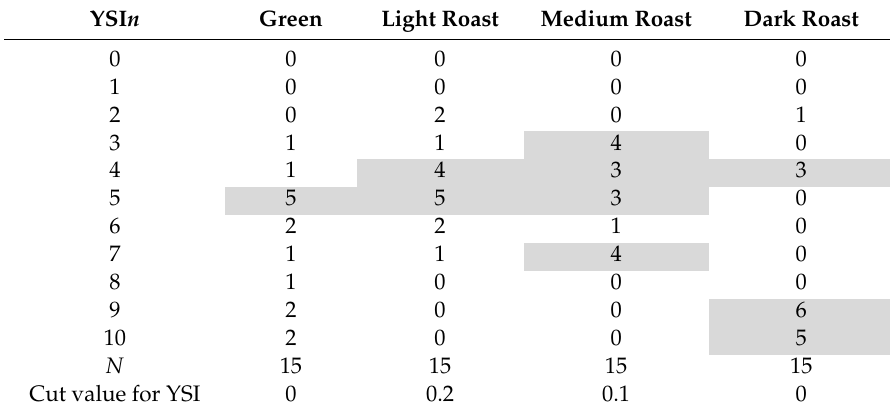
Table 2. Distribution of YSI indices by roasting level